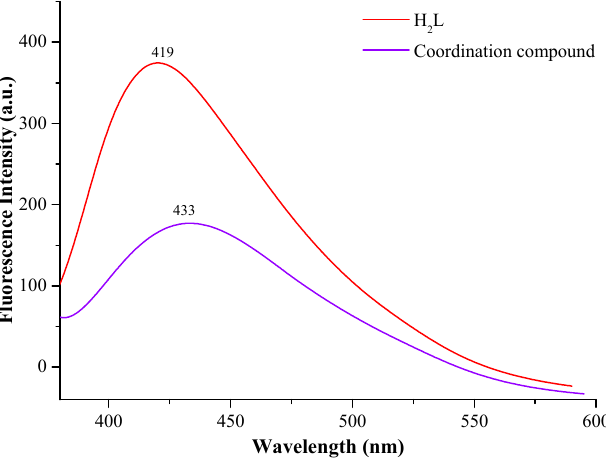
Figure 6. Emission spectra of H 2 L (c = 1 × 10 − 5 M, λ ex = 360 nm) and its Zn(II)-La(III) coordination compound.